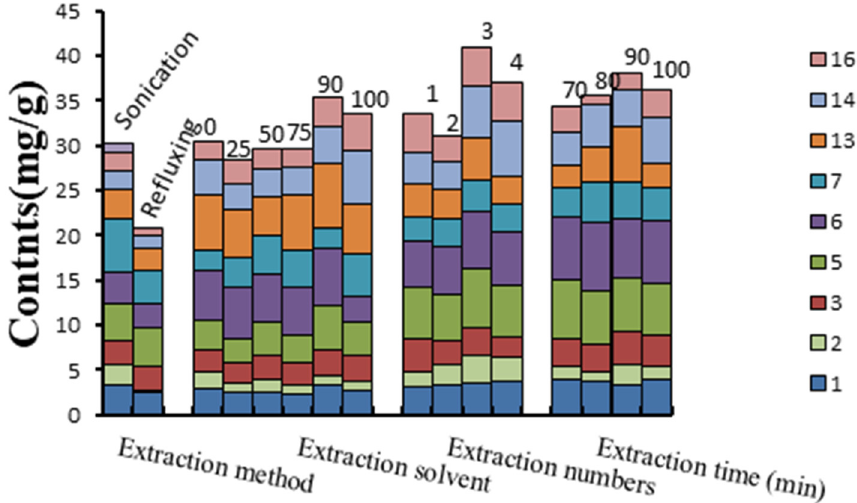
Figure 4. E ff ects of extraction method, solvent, number and time on the extraction e ffi ciency of investigated standards in the sample (BPSX) of F. esculentum pollen. Note: luteolin (1), resveratrol (2), kaempferol (3), ca ff eic acid (5), chlorogenic acid (6), rutin (7), catechin (13), quercitrin (14), and